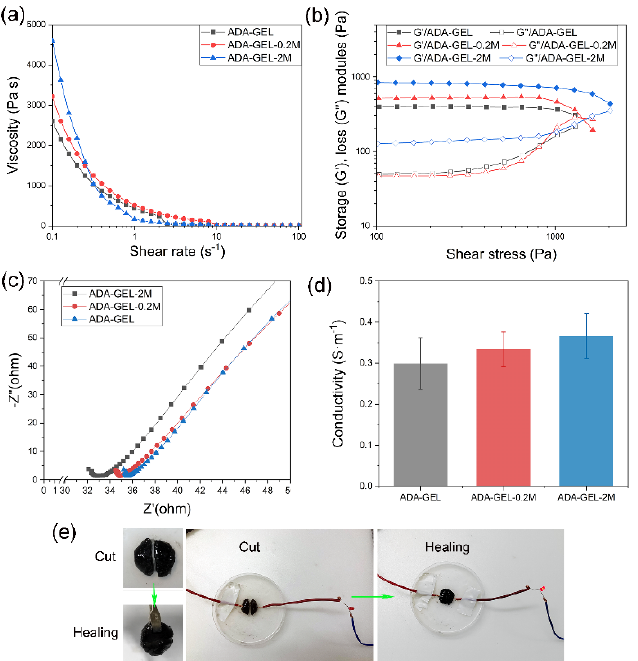
Figure 3. ( a ) Variations of viscosities with increasing shear rate and ( b ) variations of storage and loss moduli with shear stress of different hydrogels. ( c ) The Nyquist plot and ( d ) conductivity of different hydrogels. ( e ) The self-healing and the ability of MXene-ADA-GEL with a light lamp. In Section 3.2, paragraph 2: “ . . . and the conductivity increased from 2.99 ± 0.63 S m − 1 to 3.66 ± 0.55 S m − 1 when 2 w / v % of MXenes were added into the ADA-GEL” should be changed to “ . . . and the conductivity increased from 0.299 ± 0.063 S m − 1 to 0.366 ± 0.055 S m − 1 when 2 w / v % of MXenes were added into the